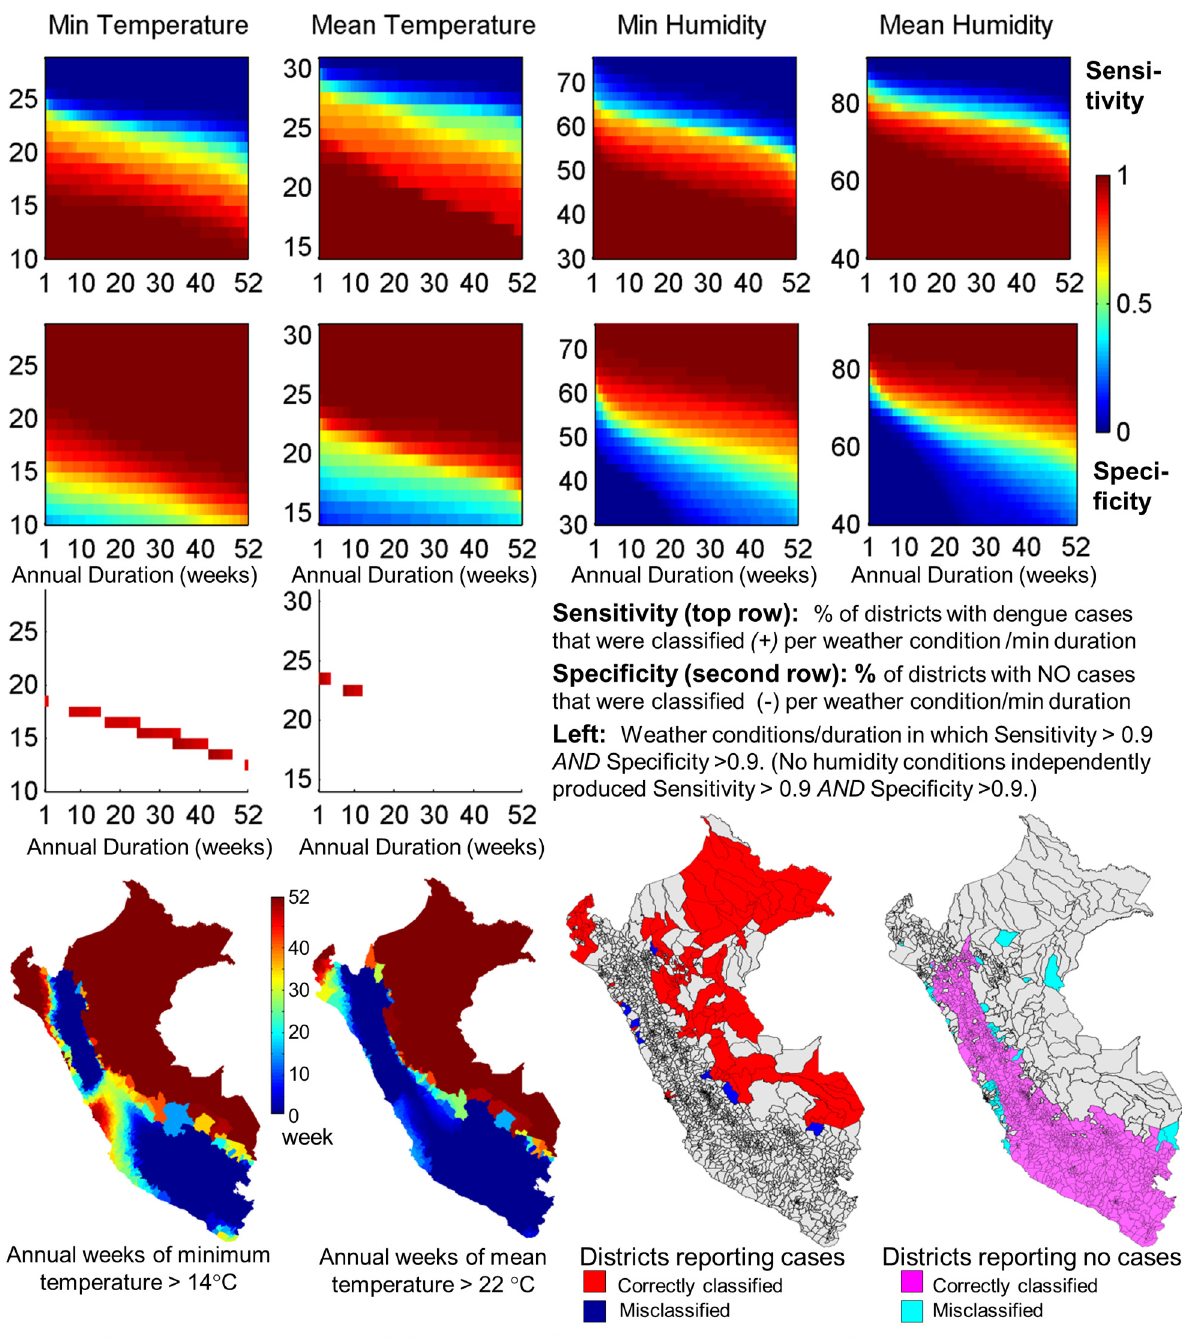
Fig 2. Classification of Peruvian districts into dengue positive and negative based on weather conditions. Top 2 rows indicate sensitivity and specificity for individual weather components, given a weather threshold and minimum duration annually above the threshold for each district. Best criteria identify weather conditions/duration when both specificity and sensitivity are high. The third row illustrates the weather conditions in which both sensitivity and specificity exceed 0.9. Results of the best classification test using minimum temperature and mean temperature combined, resulting in sensitivity = 0.95 and specificity = 0.95, are shown in the bottom row. See Table 1 for test